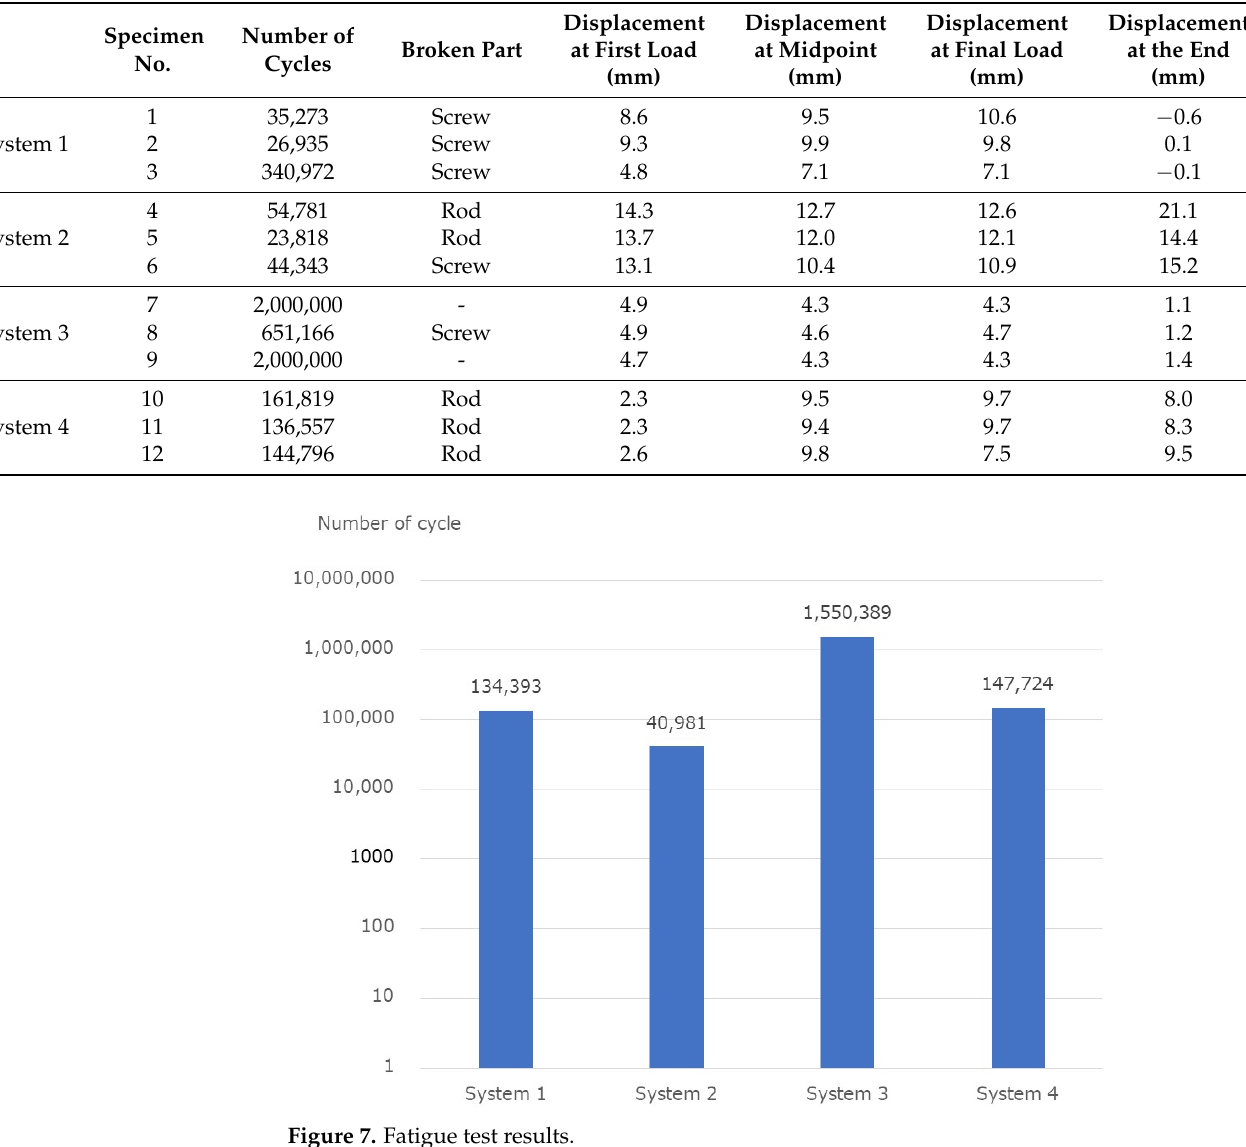
Figure 8. Fatigue test results. Displacement during one cycle at the first load, at the midpoint in the fatigue test, before the end of the test, and displacement after the end. The four systems showed statistically significant differences between them. 4. Discussion Posterior fixation is a typical procedure for thoracolumbar fractures. Since the intro- duction of the PPS, posterior fixation with PPS has become widespread in trauma treat- ment. In fracture treatment, maintaining the correction until completing bone fusion is essential. The connecting parts, rods, and interfaces between the screws and the bone are